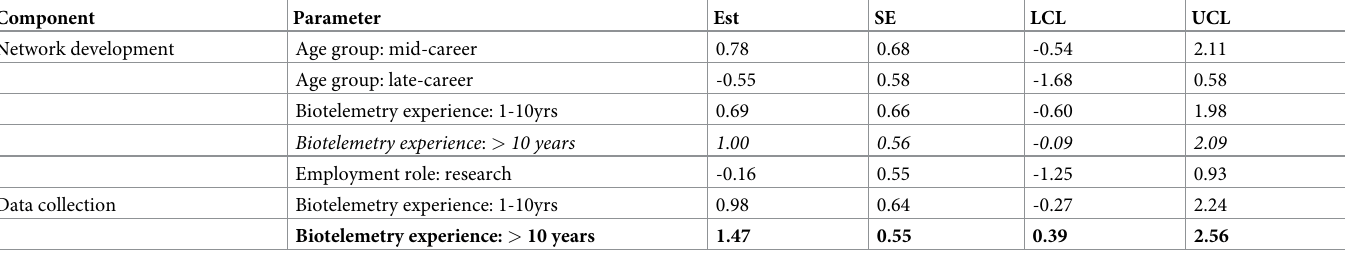
Table 4. Model averaged estimates for competing models ( Δ AICc < = 2; S2 Table) for each PCA component related to potential individual interaction with a national biotelemetry network. Component